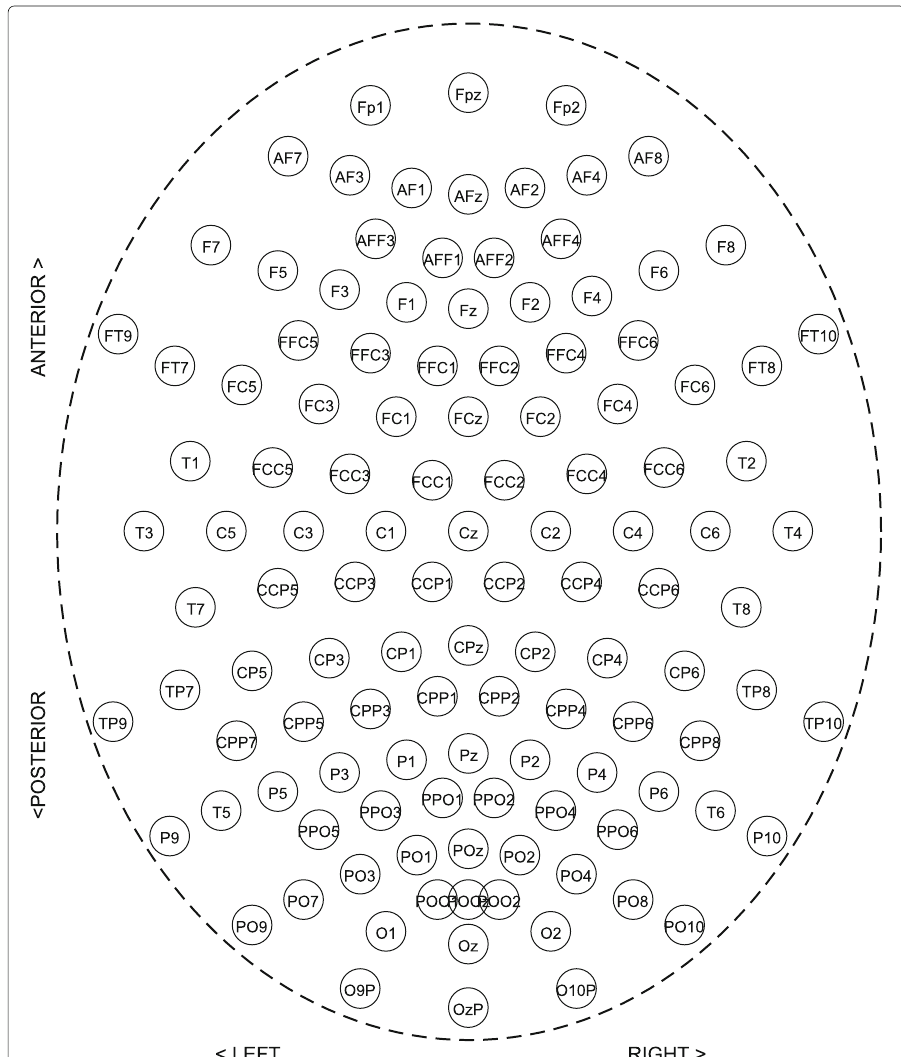
data is still vital for facilitating the interpretation of the data by neuroscientists, who are trained in reasoning with respect to spatial brain regions. Hence, node-link diagrams are often accompanied by a separate picture showing the position of nodes, with nodes on the two representations being matched by color encoding or labeling (Nelson et al. 2010). In this approach, information about spatial context is not presented in a single image. Matrix representations are also popular to represent functional connectivity net- works. This approach outperforms the node-link diagram in visualizing large networks. By arranging ROIs along the rows and columns of a matrix, their spatial relations are, however, lost (Kami´nski et al.